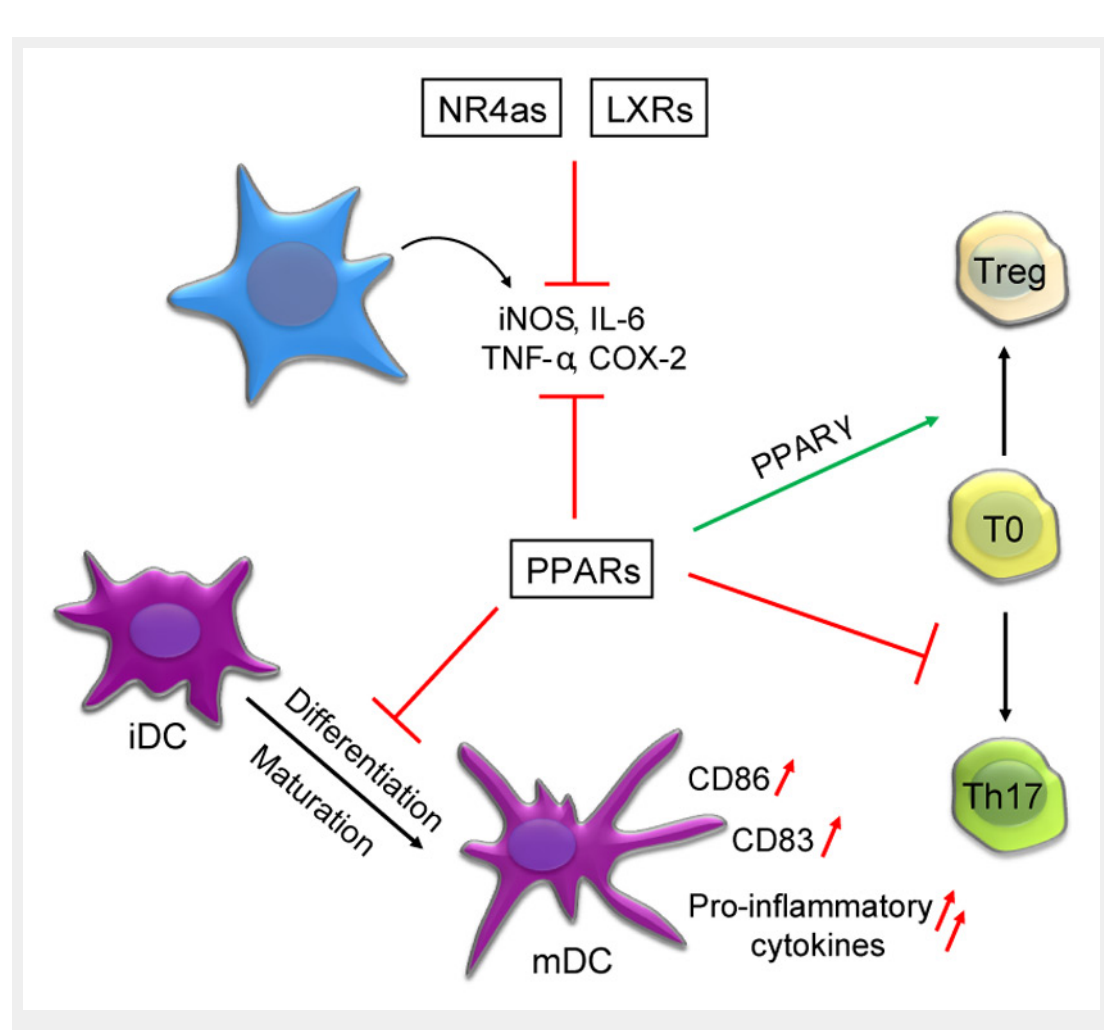
Summary of the key findings on the role of the PPAR, LXR and NR4a family of NRs during inflammation and immune homeostasis. A common feature of these families of NRs are their anti-inflammatory effects that result in the inhibition of the expression of multiple pro-inflammatory cytokines such as inducible NO-Synthase (iNOS), TNF-α, Interleukin-6 (IL-6) and cyclooxygenase-2 (COX-2). PPARs were additionally described to block the maturation of dendritic cells (DCs), which includes an attenuated expression of DC maturation markers such as CD 86 and CD83 after activation of this NR sub-family. Also differentiation of T cells into distinct subsets was shown to be influenced by NRs, where PPARs interfere with the differentiation of Th17 cells and simultaneously promote the differentiation of regulatory T cells